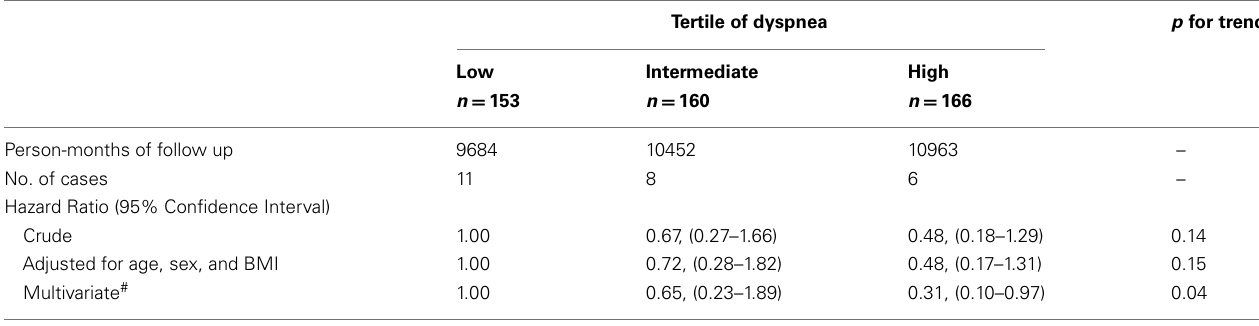
Table 3 | Hazard ratios of all-cause mortality according to dyspnea tertile ( n =